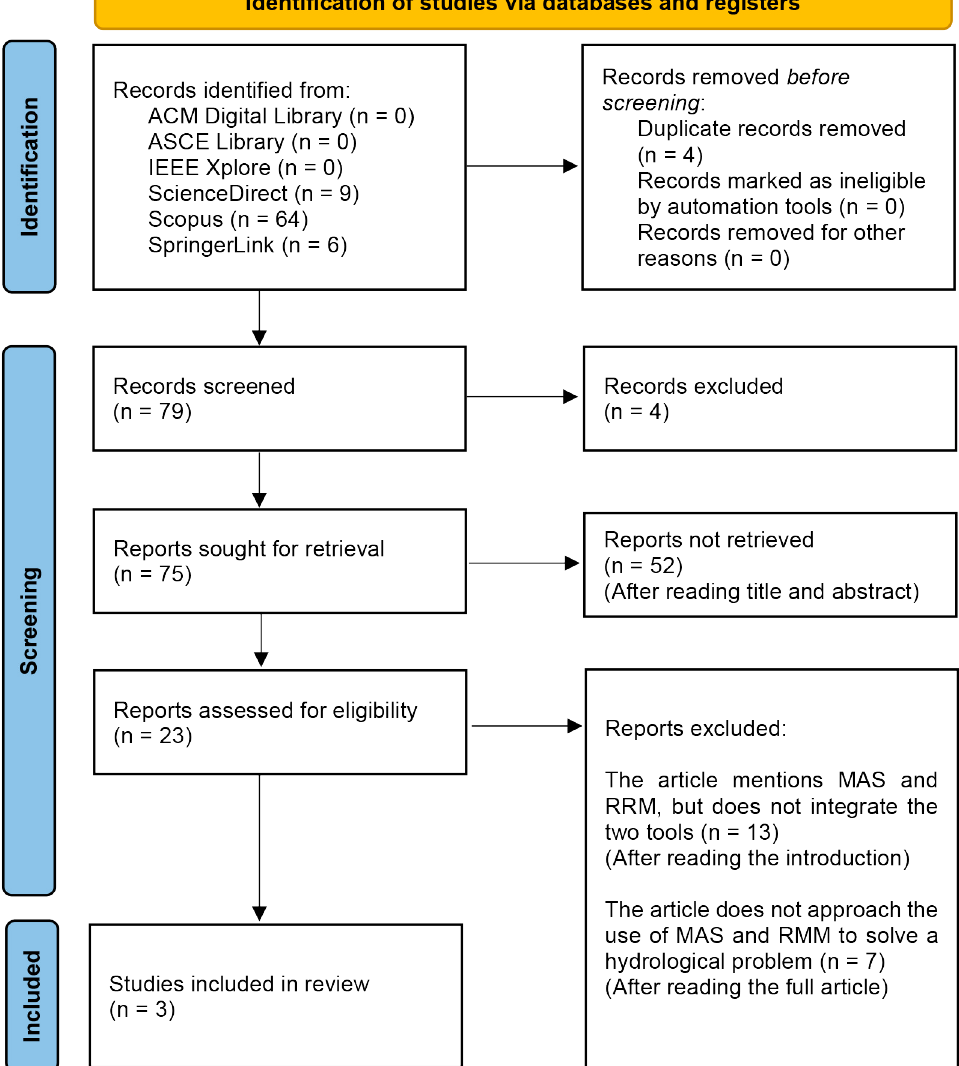
Figure 6. Systematic review processes from the selection strategy using the PRISMA 2020